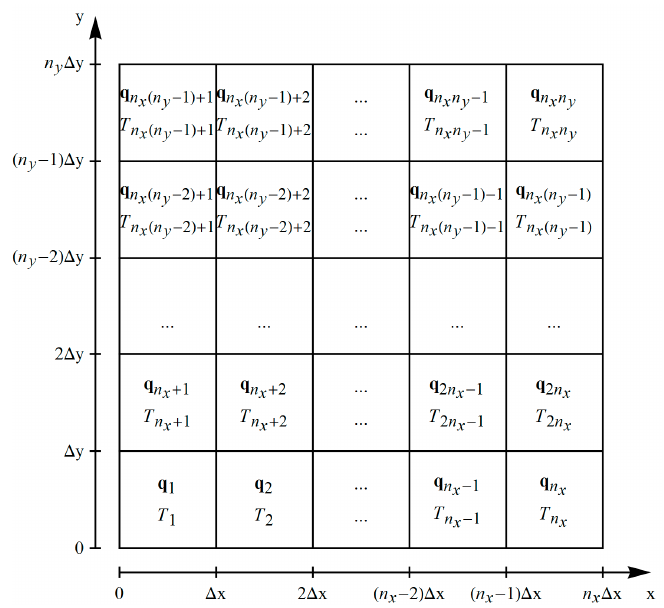
Figure 2. The graphical interpretation of the proposed discretization mesh nodes numbering [16,21].